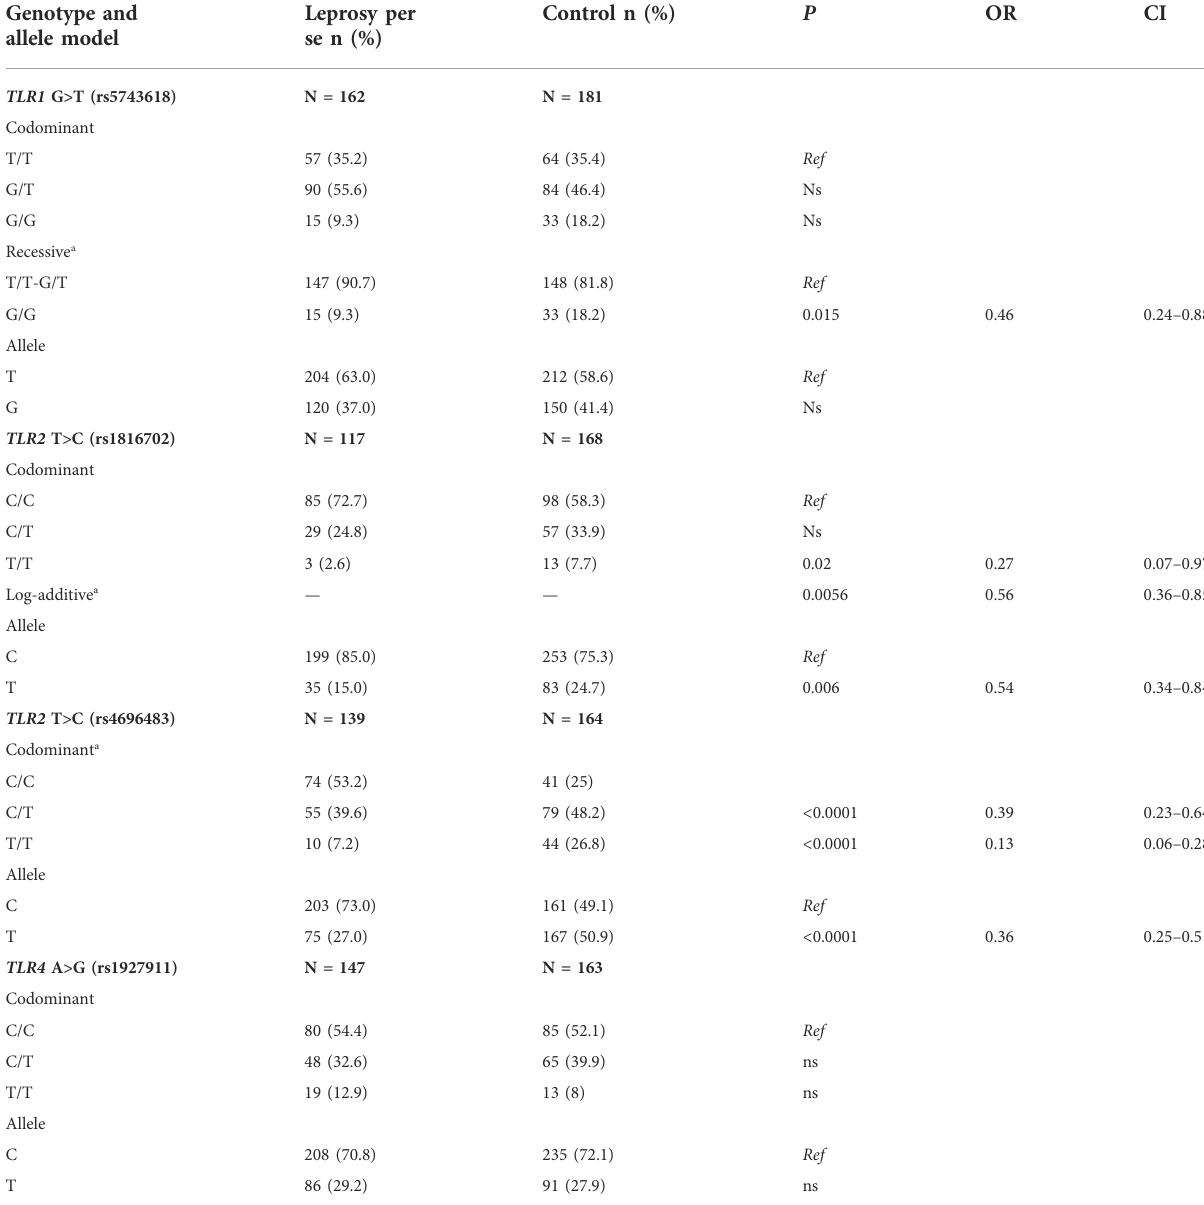
TABLE 3 TLR1 G > T (rs5743618), TLR2 T > C (rs1816702), TLR2 T > C (rs4696483), and TLR4 A > G (rs1927911) genotype and allele frequency distributions between leprosy patients and control group. Genotype and allele